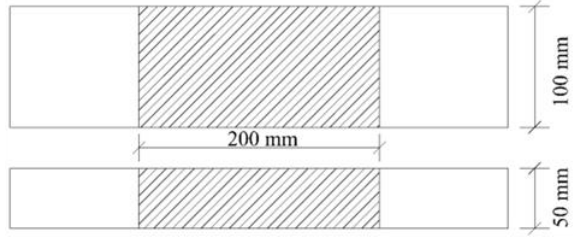
Figure 2. The specimen sizes of type I (100mm) and II (50mm).